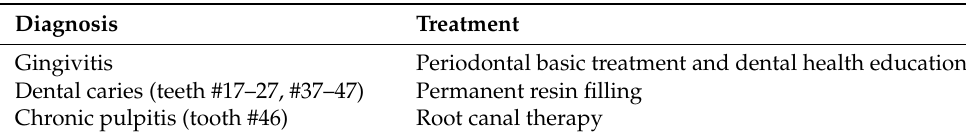
Table 1. The diagnosis and treatment of the patient.